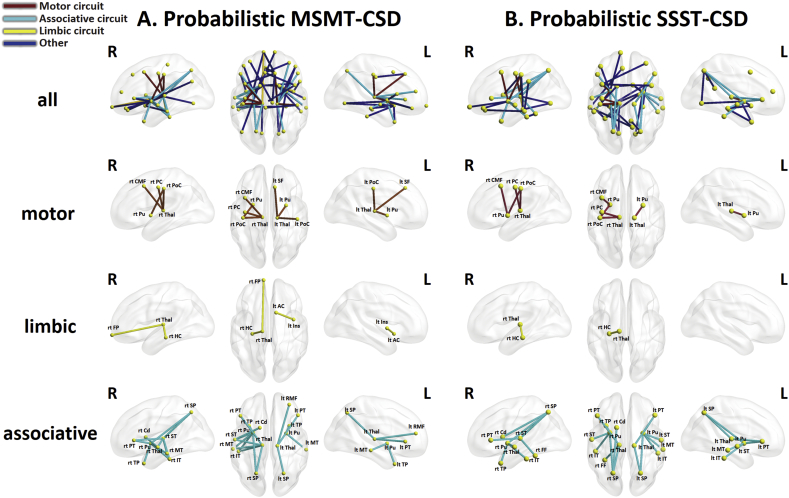
Subnetworks for which the streamline count was significantly reduced in patients with PD relative to healthy controls.(A) Result of probabilistic MSMT-CSD. (B) Result of probabilistic SSST-CSD. The first row shows all connections comprising subnetworks associated with significant between-group differences. The second, third, and fourth rows show these connections stratified according to motor, limbic, and associative circuits, respectively. Abbreviations: L, left hemisphere; R, right hemisphere; AC, accumbens; Cd, caudate; CMF, caudal middle frontal gyrus; CSD, constrained spherical deconvolution; FP, frontal pole; FF, fusiform gyrus; HC, hippocampus; Ins, insular; IT, inferior temporal gyrus; MSMT, multi-shell multi-tissue; MT, middle temporal gyrus; PC, precentral gyrus; PoC, postcentral gyrus; PT, pars triangularis; Pu, putamen; RMF, rostral middle frontal gyrus; SF, superior frontal gyrus; SP, superior parietal gyrus; SSST, single-shell single-tissue; ST, superior temporal gyrus; Thal, thalamus; TP, temporal pole.